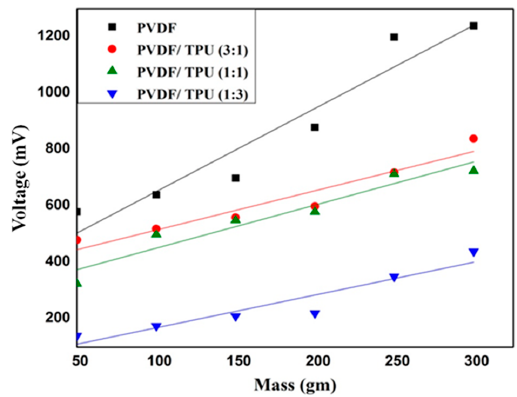
Figure 6. Piezoelectric response of different PVDF/TPU nanofibrous composite membranes under different impulse weight loading from 1 cm height.